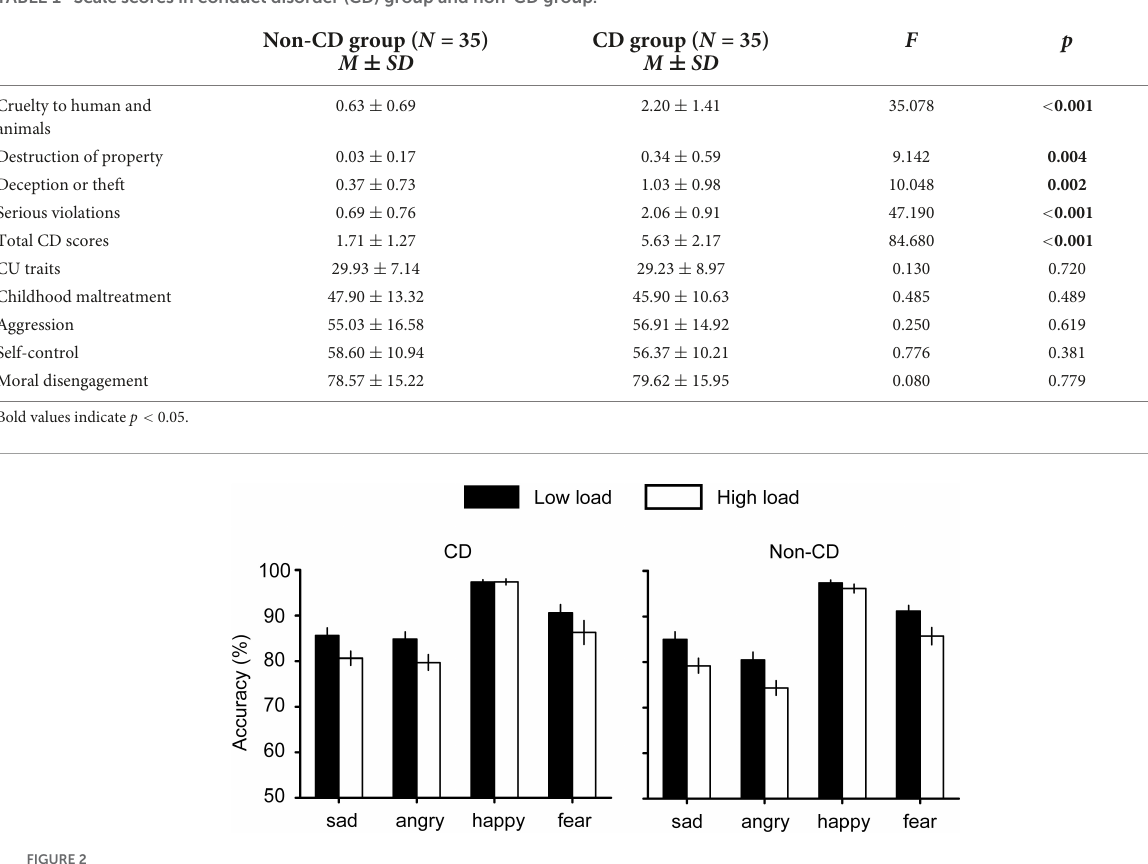
FIGURE3 Reaction time (RT) results for the visual search task.